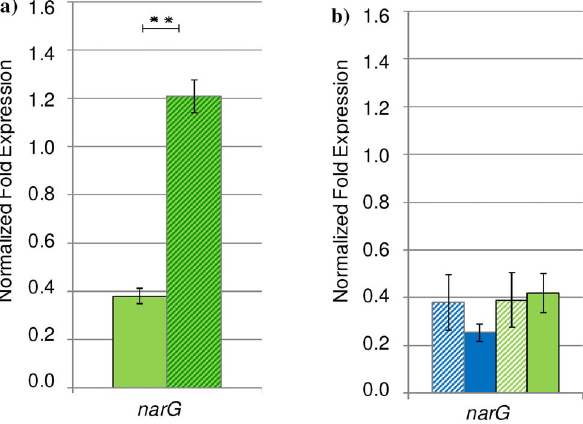
Figure 4. Expression of the nitrate redutase gene narG quantified via qRT-PCR. P. aeruginosa PAO1 was grown as colony biofilms under a) anaerobic conditions on AUM supplemented with 50 mM nitrate in the absence (uni) and presence of additional 7 mM iron (strips) and b) aerobic conditions on AUM (green) or 10-fold diluted LB (blue) in the absence (strips) and presence (uni) of 25 mM nitrate without additional iron at 37 u C up to the late logarithmic growth phase. The results are expressed as mean value + / 2 SD of three independent experiments performed in triplicate.